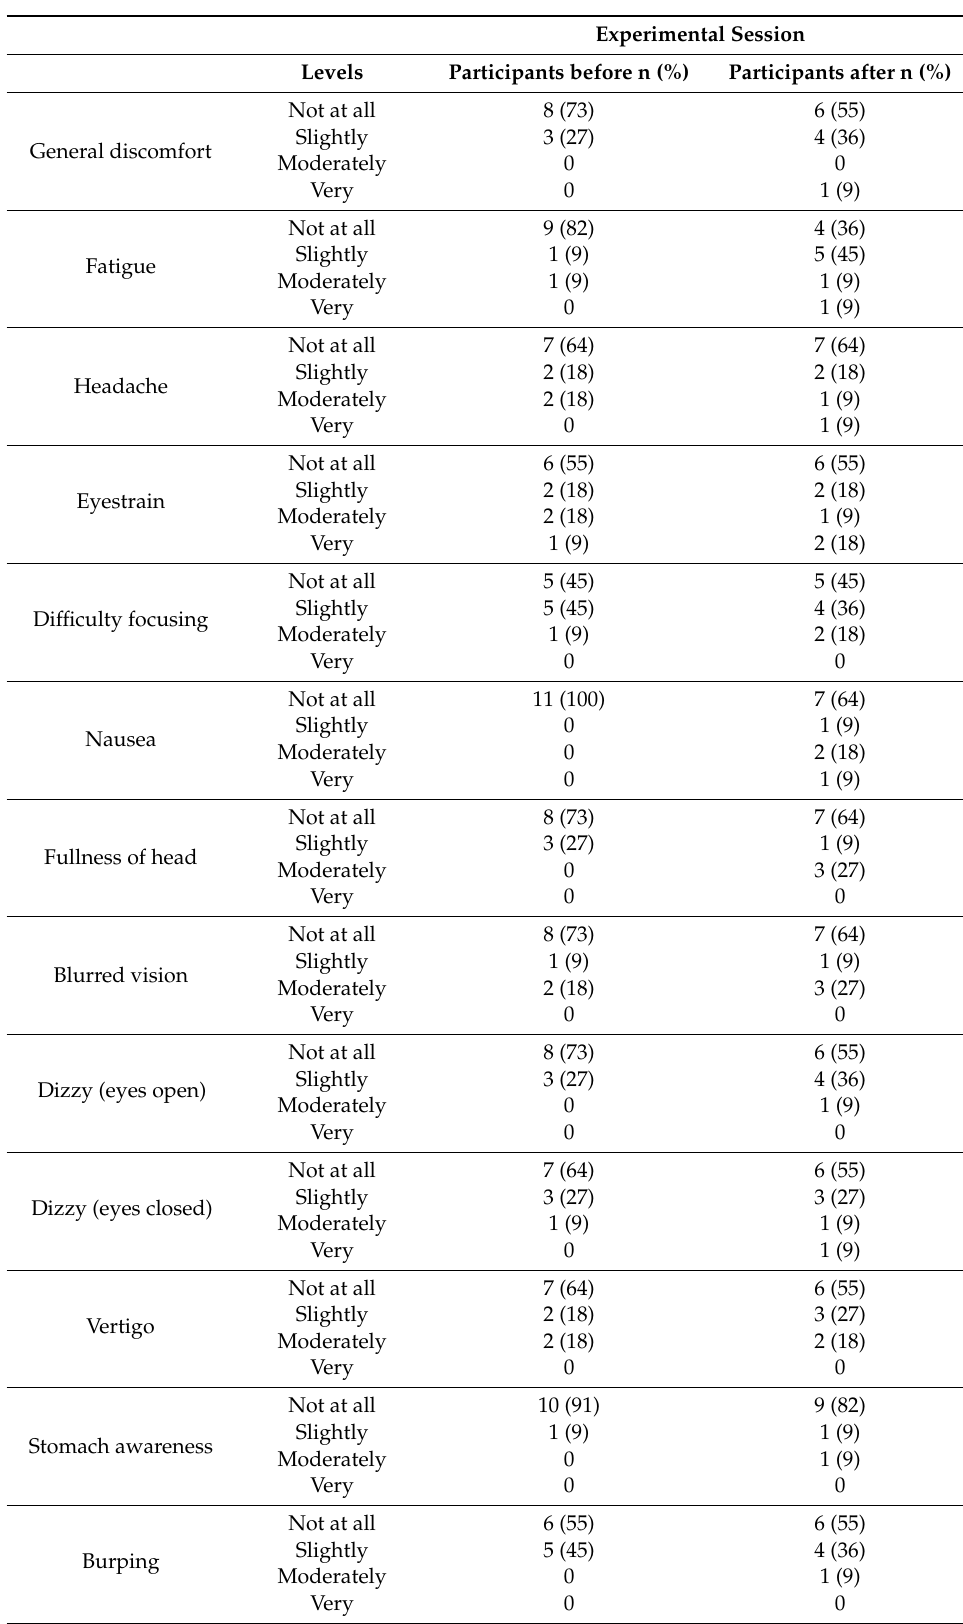
Table 1. Results of the simulation sickness